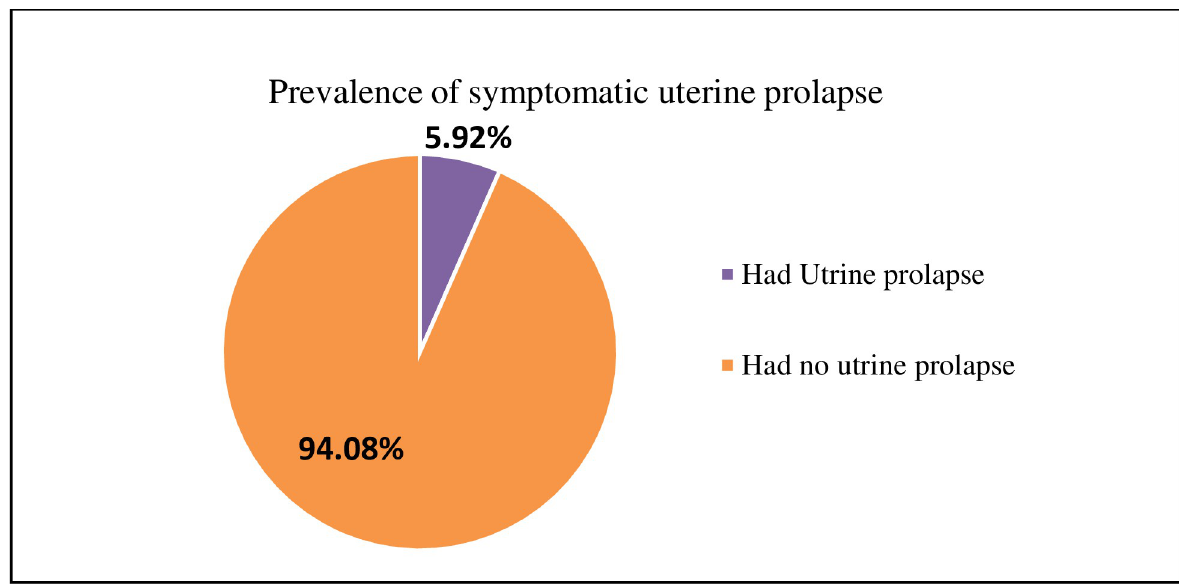
Fig 2. Prevalence of symptomatic uterine prolapse in Loma Woreda, Dawuro Zone, Ethiopia 2020 (n = 422).